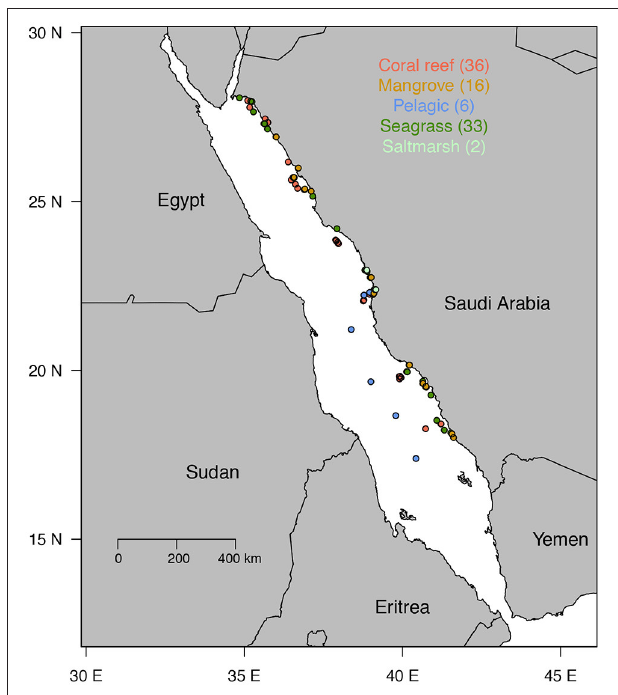
FIGURE 1 | Map indicating the study sites. Colors represent the different types of habitats with in parenthesis the number of sites surveyed for each habitat.